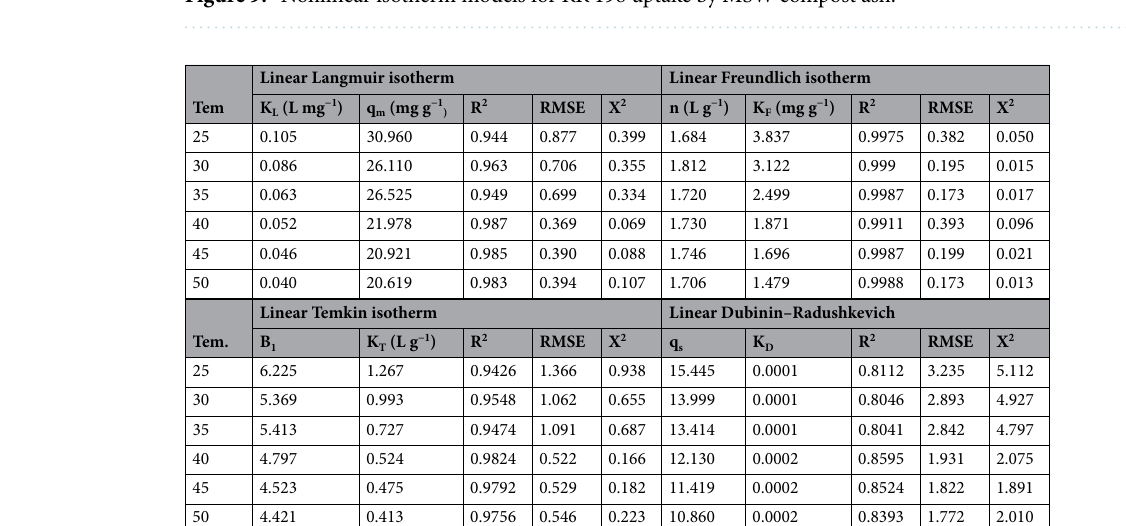
Figure 9. Nonlinear isotherm models for RR 198 uptake by MSW compost ash.